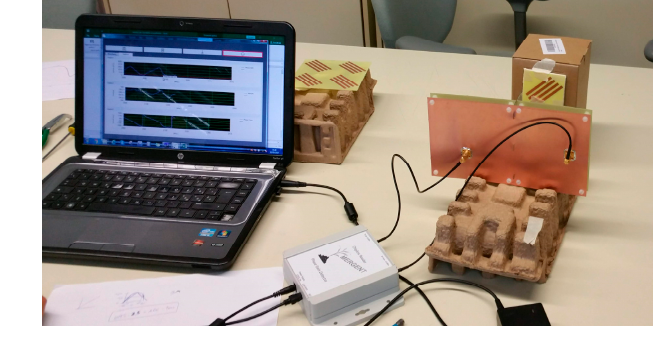
Figure 9. Measurement setup.